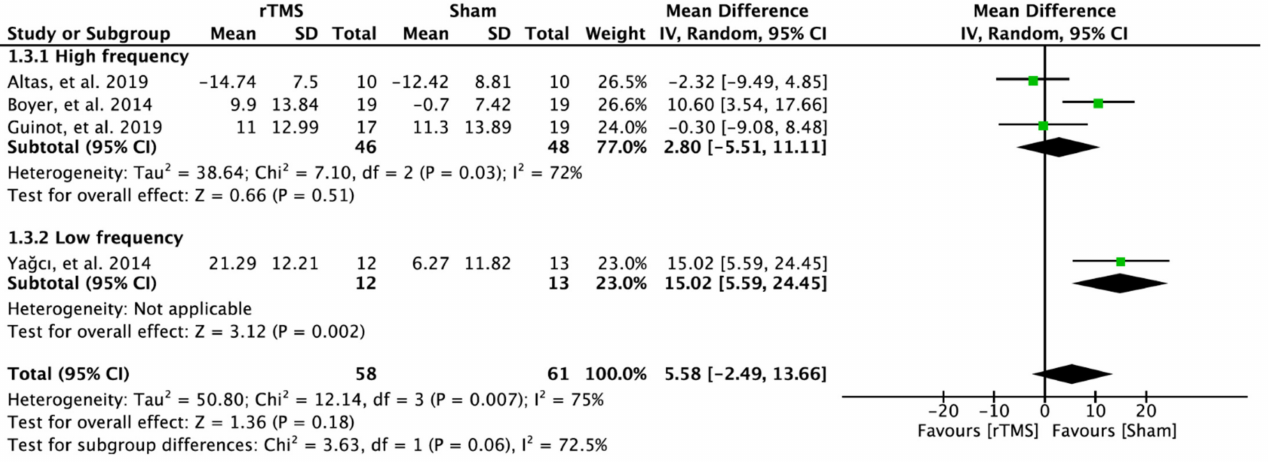
Figure 5. Forest plot on the effect of repetitive transcranial magnetic stimulation on health